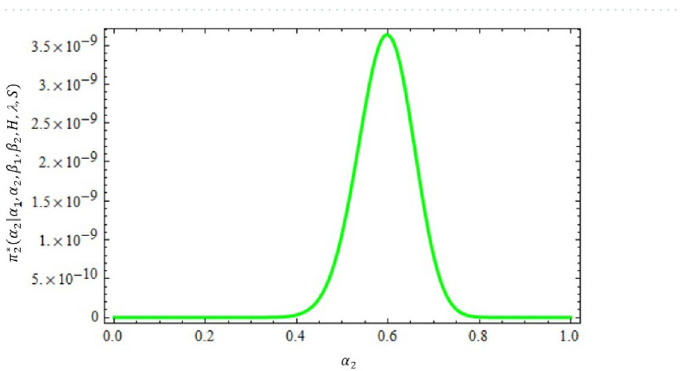
Figure 3. The conditional posterior density of MCMC results of the α 1 parameter.